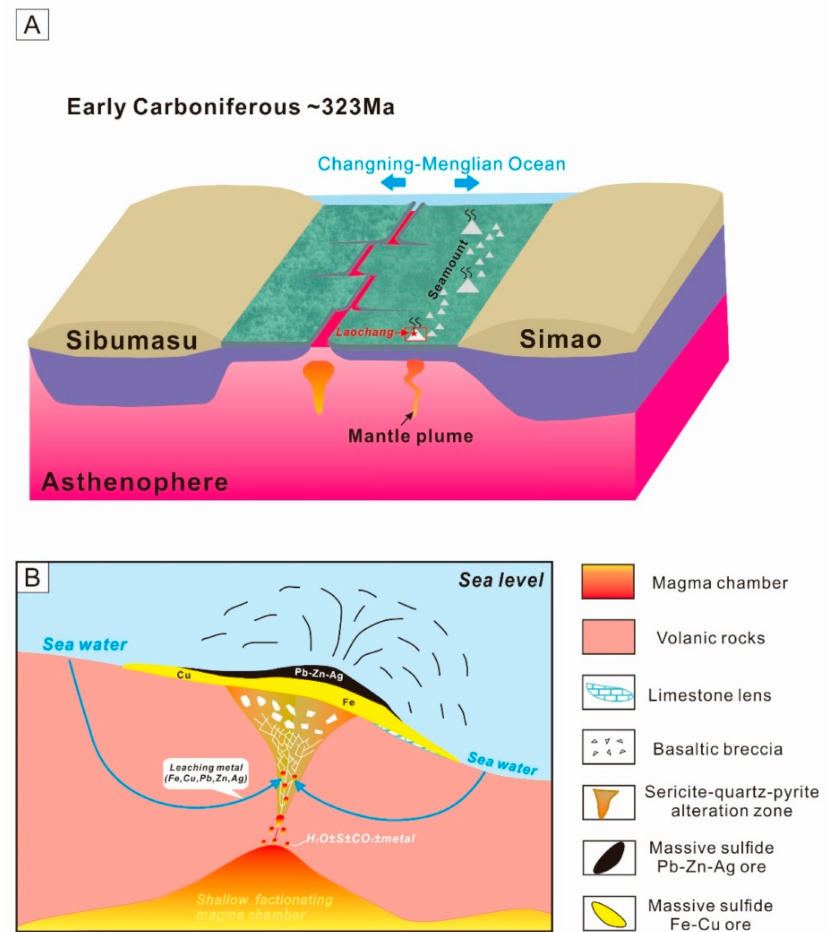
Figure 15. ( A ) General sketch shows the tectonic setting of the Laochang ore deposit. ( B ) Proposed genetic model for the Laochang Ag-Pb-Zn-Cu deposit. High temperature, high salinity, metal-charged (Fe, Cu, Pb, Zn, and Ag) and H 2 S-rich fluids were degassed directly from the shallow